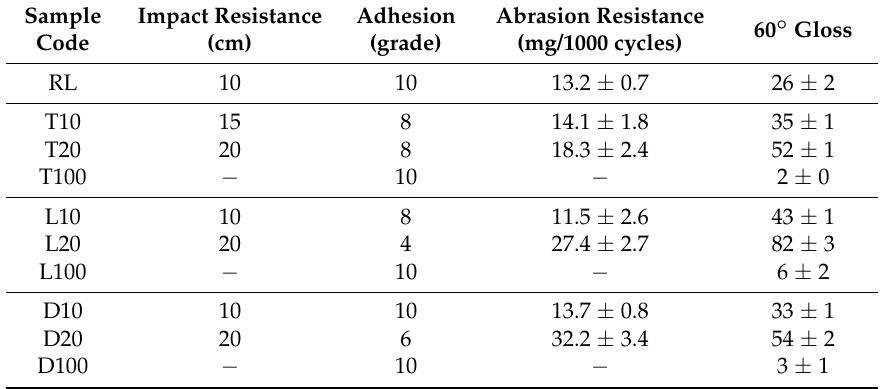
Table 3. The impact resistance, adhesion, abrasion resistance, and gloss of OMRL